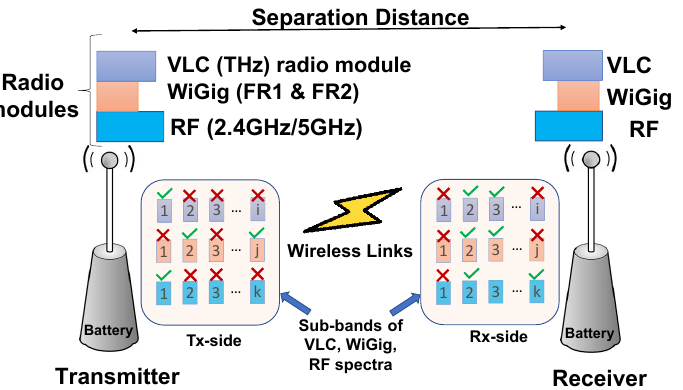
Figure 1. Hybrid band system model: How to self optimize hybrid channels in fluctuating channel conditions (distance, energy level, and